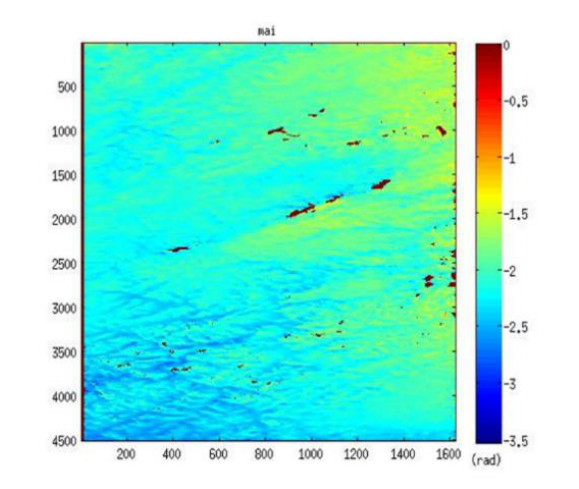
Figure 2. Original MAI interferogram